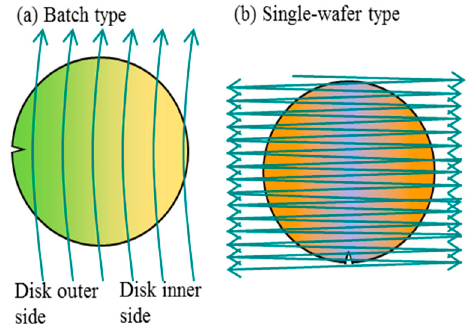
Figure 10. Damage distribution illustrations [17]. Arrows denote beam scans. ( a ) Batch type: the damage is smaller and more uniform. The damage at the disk inner side is slightly larger; ( b ) single-wafer type: the damage at the left side and the right side is largest.